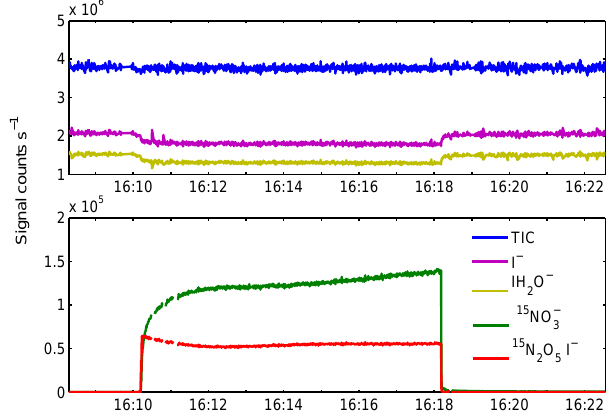
Figure 1. An example of collision-limited sensitivity determination of the ToF-CIMS. Top: the reagent ions and sum of total ions dur- ing the addition of high concentrations of 15 N 2 O 5 to the inlet of the ToF-CIMS. By calibrating the output of our N 2 O 5 source indepen- dently (in this case by the UC, Berkeley TD-LiF instrument, Day et al., 2002), we are able to derive the collision-limited sensitivity of the instrument by adding the two detection channels as described in the text (Day et al., 2002; Huey et al., 1995). As total ion current (TIC) remains constant during the experiment despite the depletion of reagent ions (I − + IH 2 O–) the mass transmission efficiency be- tween 63 and 237Th is therefore